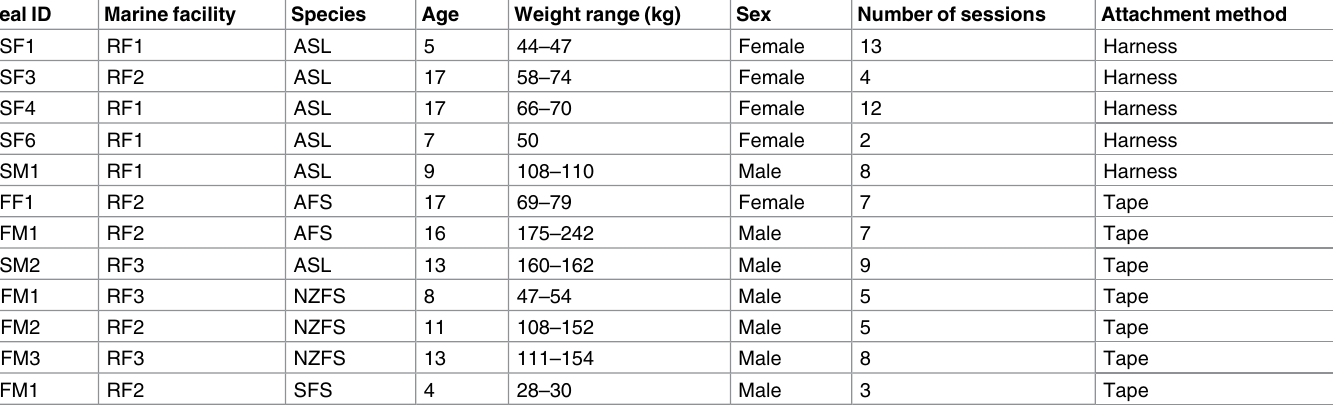
Table 1. Identification number, location, species, age weight and sex of seals with number of sessions and attachment method of accelerometer. AFS—Australian fur seal; NZFS—New Zealandfur seal; SFS—subantarcticfur seal and ASL—Australian sea lion. Seal ID